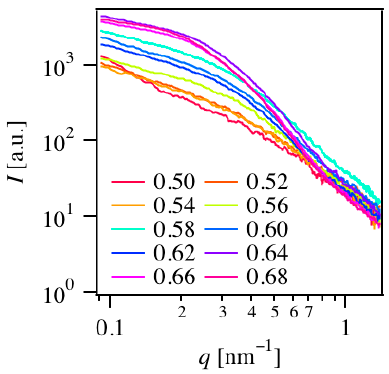
Figure 7. Circularly-averaged SAXS intensity profiles of the carboxylated SR gels at φ a = 0.50–0.68.